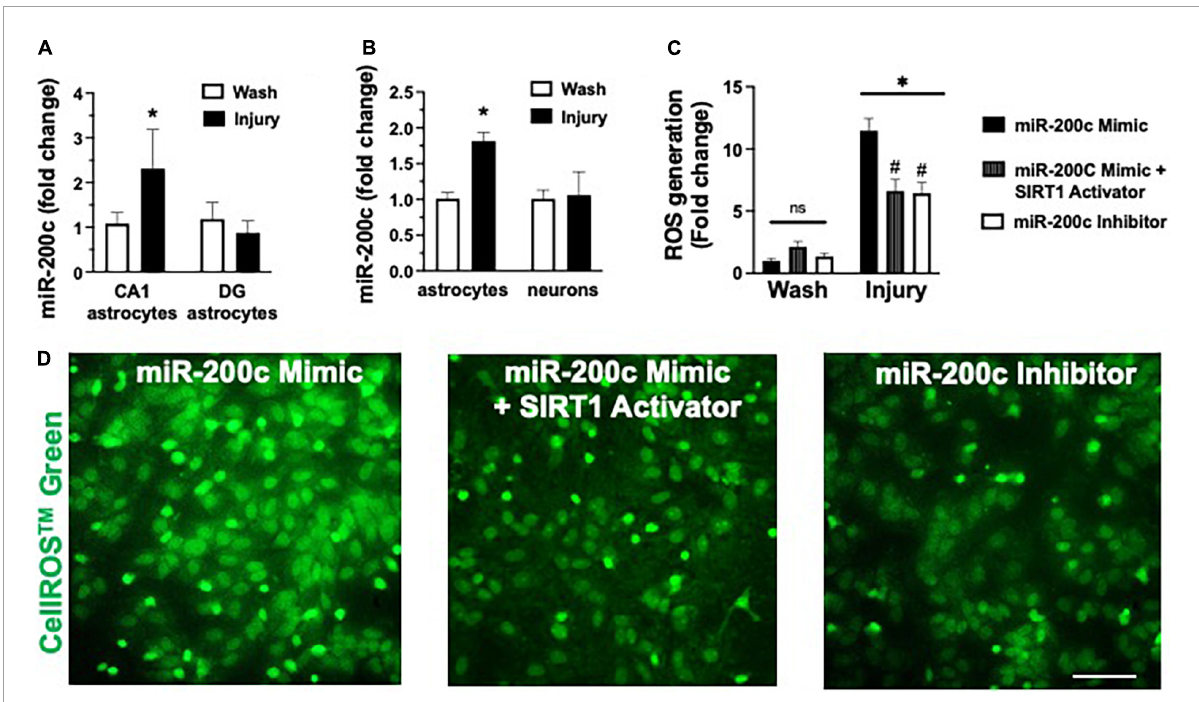
FIGURE6 Post-injury miR-200c expression and SIRT1 activation and reactive oxygen species (ROS) production in astrocyte cultures. (A) Quantification of miR-200c expression after 3 h combined oxygen glucose deprivation (OGD) injury in primary hippocampal CA1 and DG astrocyte cultures. (B) Quantification of miR-200c expression after 3 h OGD in primary cortical astrocyte and neuronal cultures. (C) Quantification of ROS production in primary astrocytes pre-treated with MM-control, miR-200c mimic, miR-200c mimic + SIRT1 activator YK 3-237, or